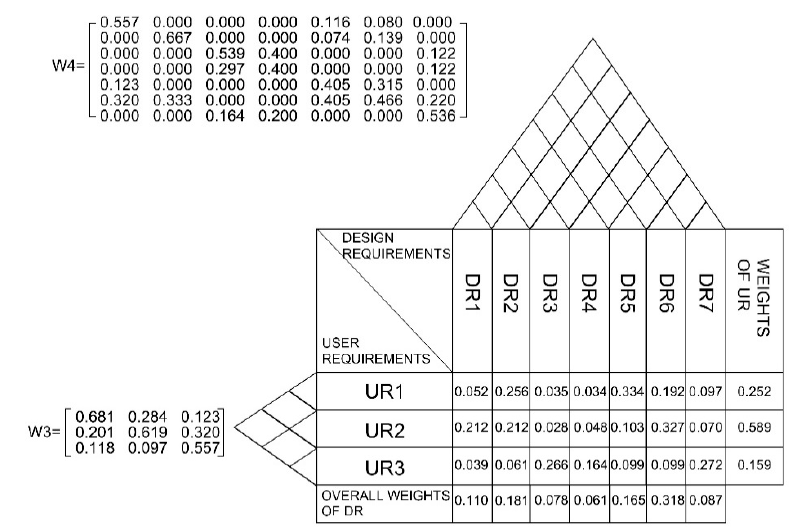
Figure 6. House of quality